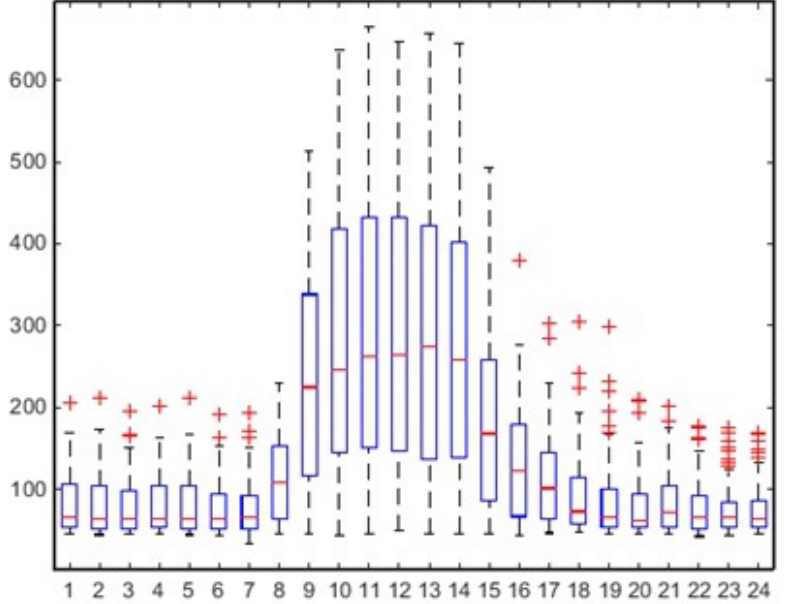
Figure 5. Pilot system: Municipal office (Monopoli). Box plots of working days power consumption. The x-axis reports day ours, while y-axis indicates power consumption (kW).